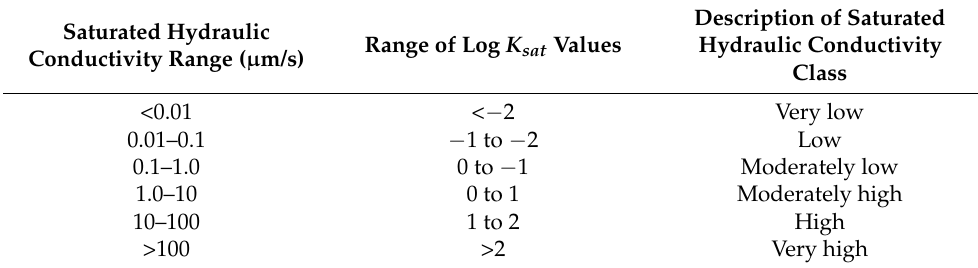
Table 1. Soil saturated hydraulic conductivity classes (Soil Survey Staff